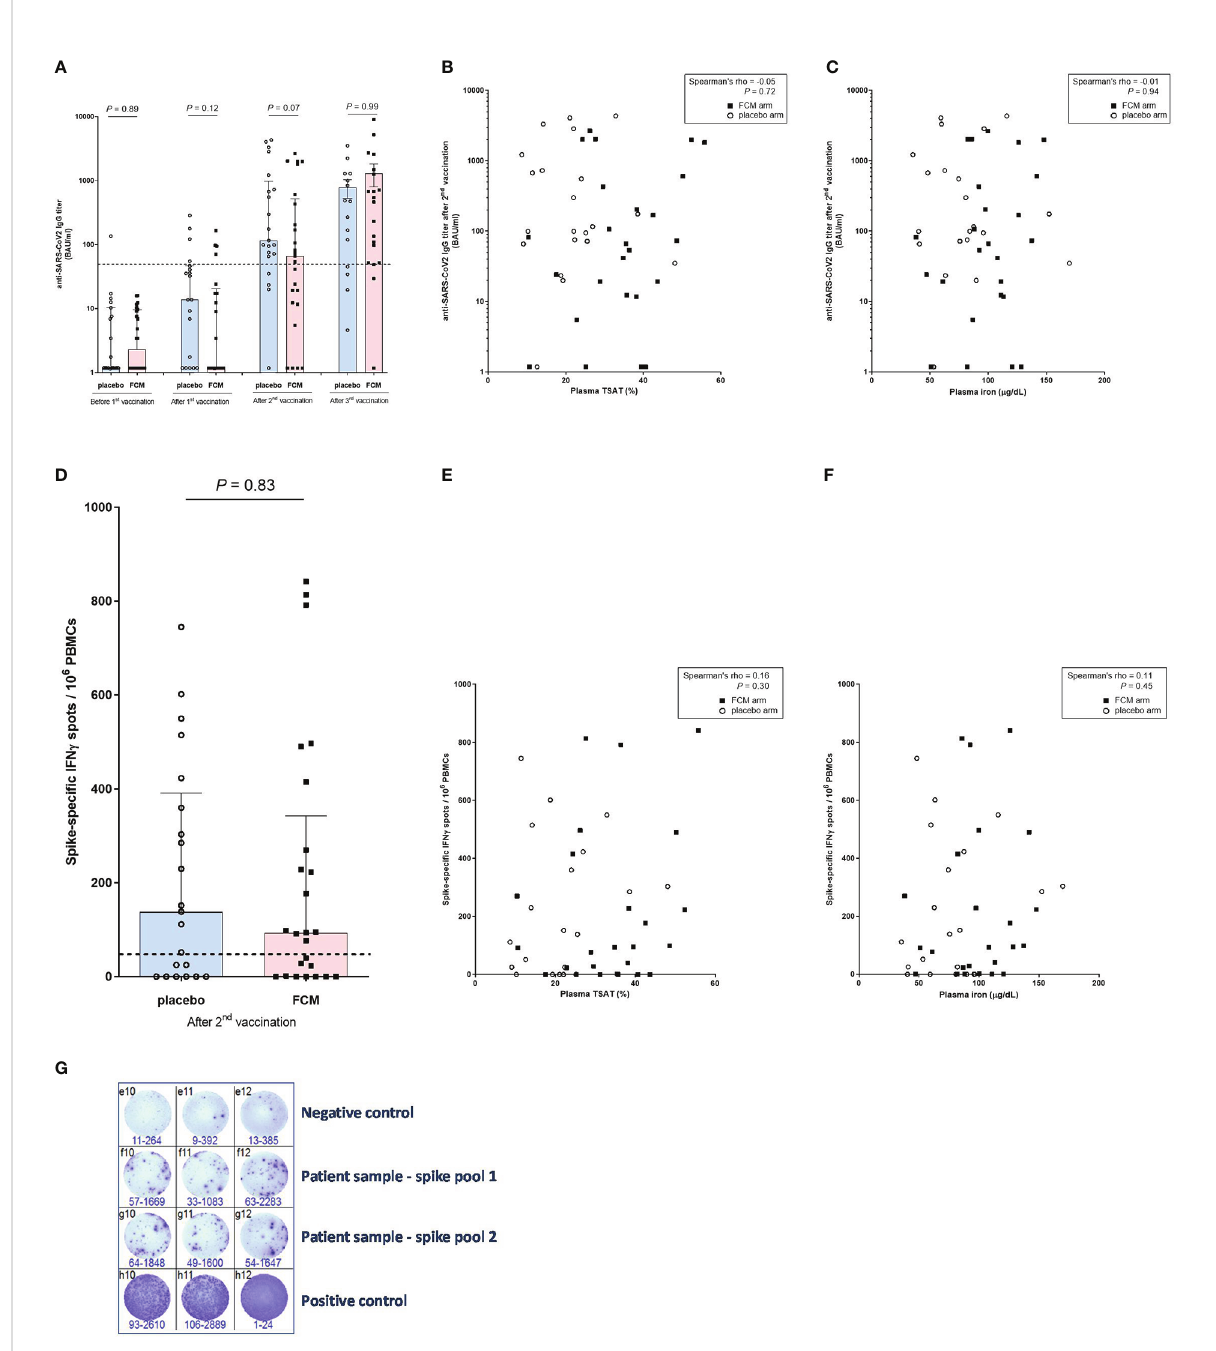
FIGURE 3 Anti-SARS-CoV-2 antibody and T-lymphocyte response. (A) Anti-SARS-CoV-2 IgG titers before vaccination and after the successive vaccinations in iron-de fi cient KTRs who had been treated with ferric carboxymaltose or placebo. The dashed horizontal line represents the threshold for IgG seropositivity. (B) Anti-SARS-CoV-2 IgG titers and transferrin saturation (in all participants). (C) Anti-SARS-CoV-2 IgG titers and plasma iron (in all participants). (D) SARS-CoV-speci fi c T-lymphocyte response in iron-de fi cient KTRs who had been treated with ferric carboxymaltose or placebo. The dashed horizontal line represents the threshold for a positive T-lymphocyte response. (E) SARS-CoV-speci fi c T-lymphocyte response and transferrin saturation (in all participants). (F) SARS-CoV-speci fi c T-lymphocyte response and plasma iron (in all participants). (G) Example of representative results of an ELISpot assay, with which the SARS-CoV-2-speci fi c T-lymphocyte response was measured in a patient (Spike pool 1 and 2). Interferon-gamma-producing T-lymphcytes after stimulation with SARS-CoV-2 Spike overlapping peptide pools are colored purple. All stimulations are performed in triplicate per peptide pool and the average of the six measurements is calculated. To correct for background activation, the average signal of the negative control is subtracted from the spike